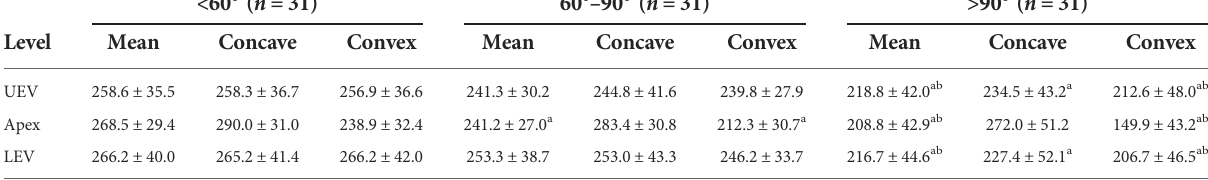
TABLE 5 Comparison of VB-HU at Apex, UEV, and LEV within major curve among subgroups.